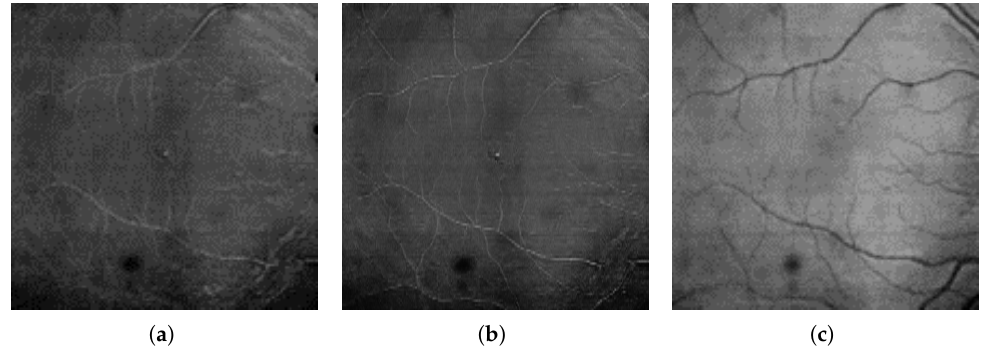
Figure 3. Example of projections obtained from selected retina layers: ( a ) GCL layer projection, ( b ) GCL+IPL layer projection, ( c ) OS+RPE layer